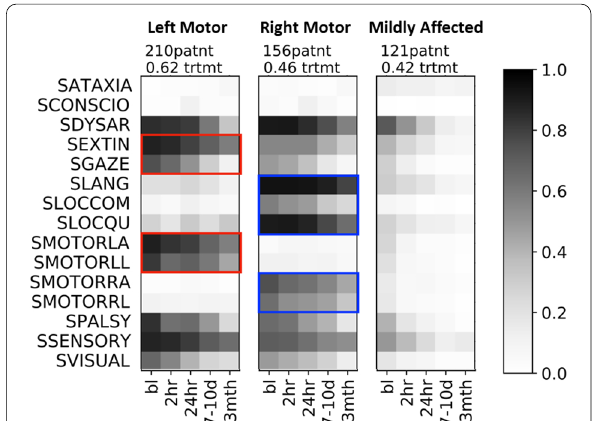
Fig. 3 Corresponding profiles of the 3 stroke recovery subtypes. Subtypes identified by the algorithm containing fewer than 10 patients are not shown (1 outlier patient falls under this category). The shade of grey indicates the affected fraction, i.e., fraction of patients in the recovery subtype that are severely affected by that symptom at that time. The number of patients in the subtype, and fraction of patients receiving treatment is listed above each panel. The symptom names are listed to the left. The red boxes highlight the unique combination of dominant symptoms of the ‘left motor’ subtype. The blue boxes highlight the unique combination of dominant symptoms of the middle ‘right motor’ subtype. The rightmost ‘mildly affected’ subtype has the mildest symptom profile. The symptoms names on the left are preceded by the letter ‘S’ (indicating ‘Stroke’) to be consistent with the naming convention in the